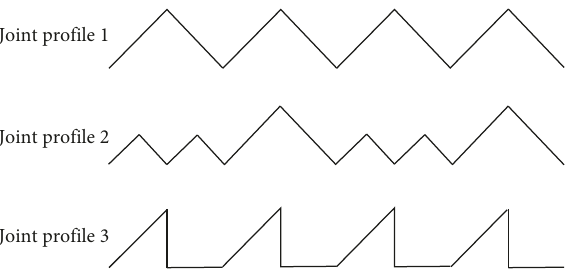
Figure 2: Joint profiles with different surface